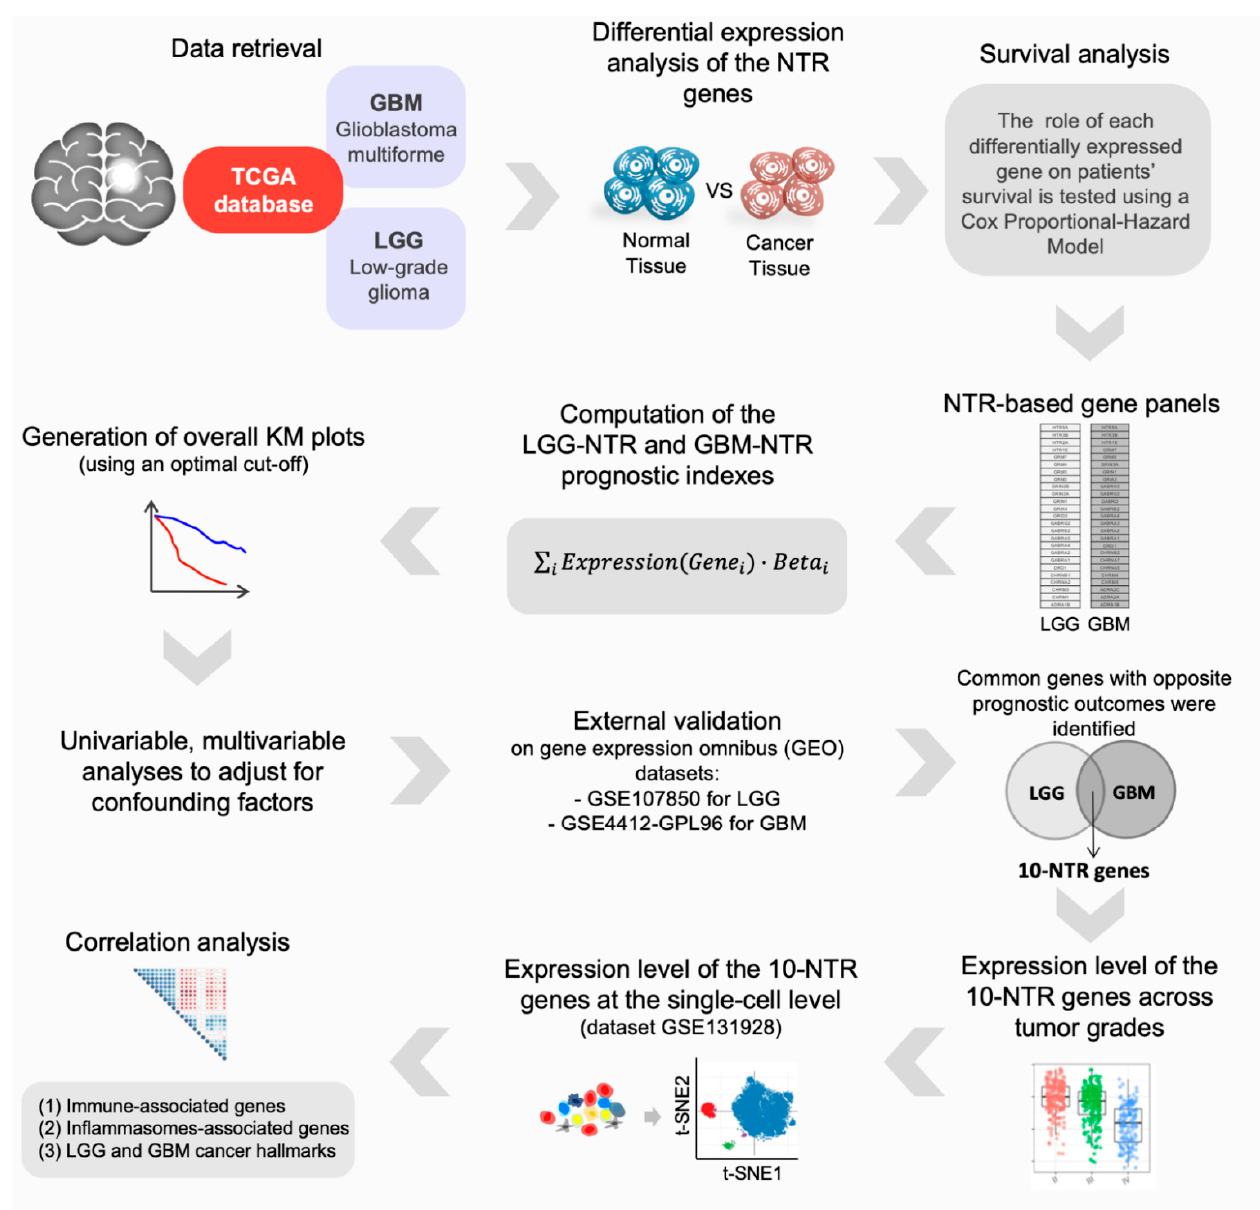
Figure 1. Schematic of the bioinformatic pipeline. We first identified the NTR genes that were differentially expressed in LGG and GBM tissue; then, we investigated their prognostic value. We constructed two gene panels and prognostic indexes (LGG-NTR and GBM-NTR) and we used them to stratify patients into risk groups. We performed univariable and multivariable analyses to adjust for confounding factors and validated both prognostic indexes on independent datasets. Next, we sought to find common genes between the two panels that had an opposite association with the patients’ survival and we analyzed their expression levels across progressive grades in two independent datasets as well as at the single-cell level. Finally, we evaluated the correlation between these genes (10-NTR) and genes associated with immune response, inflammasomes, and cancer hallmarks specific for LGG and